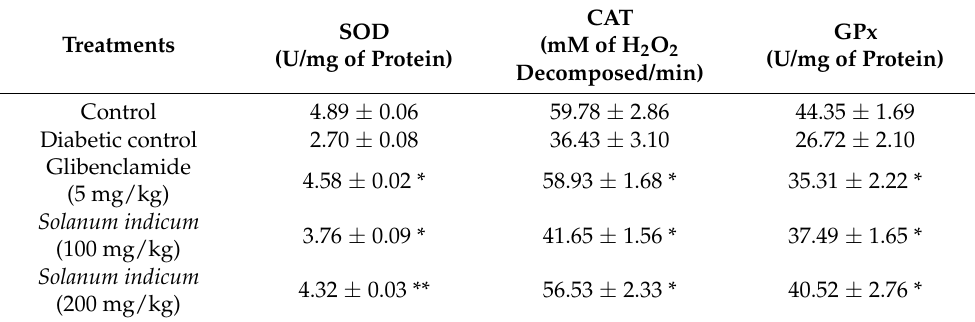
Table 8. Changes in SOD, CAT and GPx activities of normal and diabetic rats after 30 days of treatment with the extract of Solanum indicum